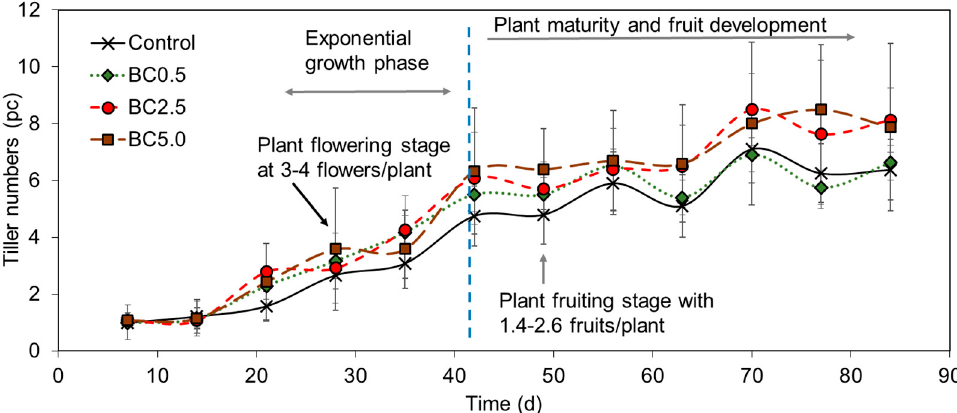
Figure 2. Overview of plant growth and maturing phases based on average tiller numbers over time. n = 8 to n = 14, ± SD. Dashed line represents the growth phase change from exponential growth to fruit development phase.